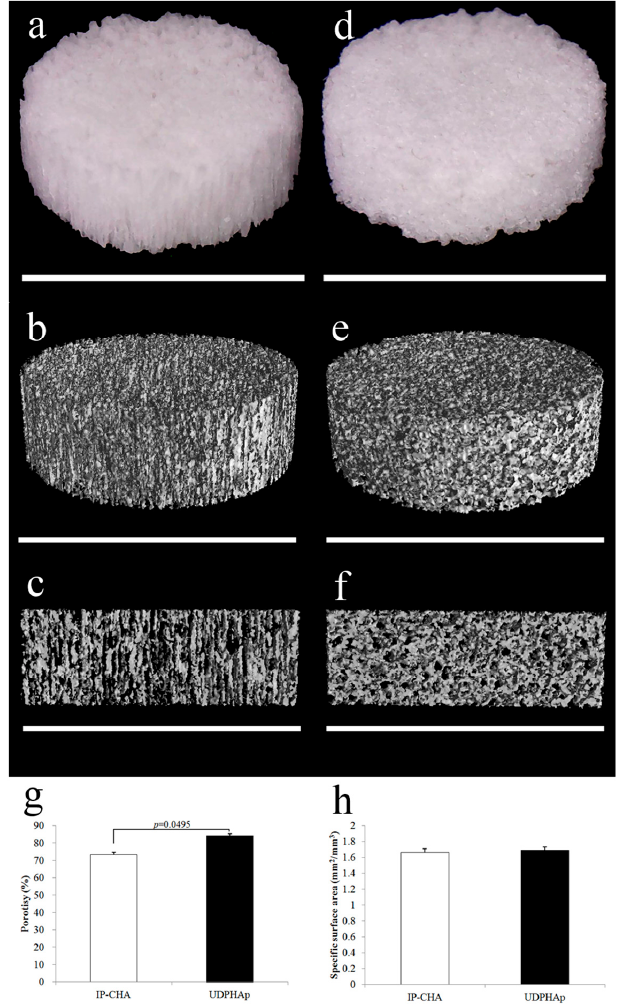
Figure 1. Representative photographs and Micro-CT analysis of porous hydroxyapatite scaffolds. Gross appearance and 3D image renderings from micro-CT scans of ( a – c ) UDPHAp and ( b – d ) IP-CHA. White bars are 5 mm; ( g ) Porosity and ( h ) SSA of UDPHAp and IP-CHA. Values are mean ± SD; n = 3 analyzed by Mann-Whitney U test.